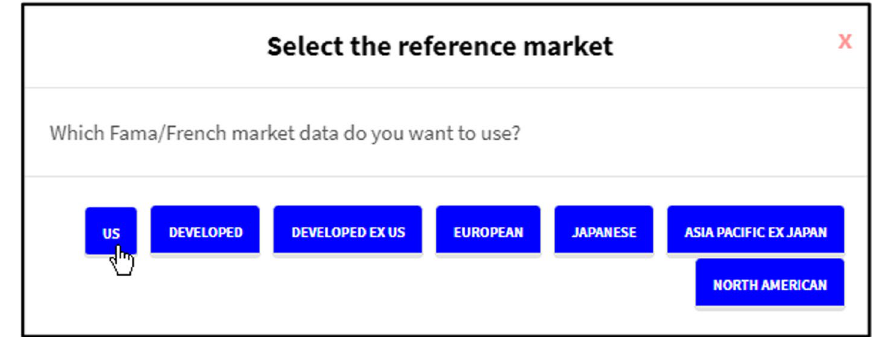
Fig. 17 Kenneth R. French market portfolio selection pop‑up. Source : Created by